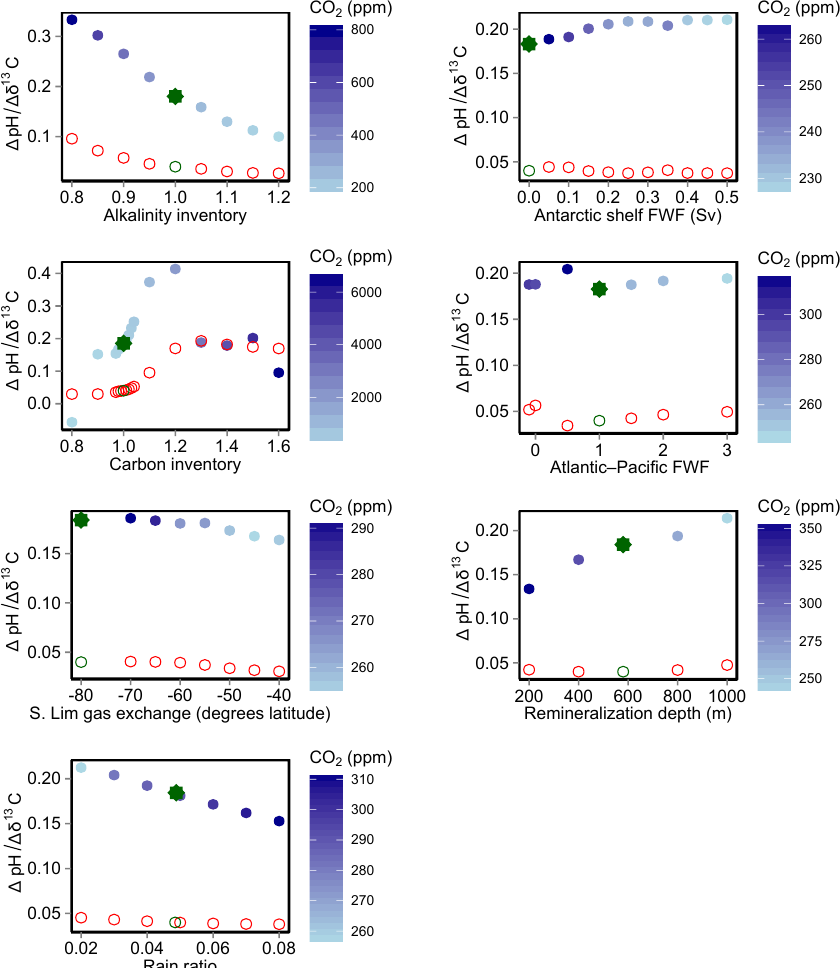
Figure 7. The output from GENIE sensitivity analysis showing the warm surface-to-cold deep (cid:49) pH– (cid:49)δ 13 C relationship. A pre-industrial model set-up was taken and perturbations were made to alkalinity inventory, carbon inventory, Antarctic shelf freshwater flux (Sv), Atlantic– Pacific freshwater flux, S . Lim gas exchange (blocks air–sea gas exchange south of the stated latitude), remineralization depth scale (m) and rain ratio – as described in the methods section. Blue circles depict the (cid:49) pH– (cid:49)δ 13 C relationship (where the colours reflect the CO 2 level of each experiment) and red open circles show the RMSE. The green stars are the (cid:49) pH– (cid:49)δ 13 C relationship for the control experiment conducted at 292.67ppm CO 2 . The green (open) points show the RMSE for this control run. Inventories are dimensionless (1 is control). For the Atlantic–Pacific FWF 1 is equivalent to 0.32Sv. The alkalinity and carbon inventory experiments are very extreme and inconsistent with geologic